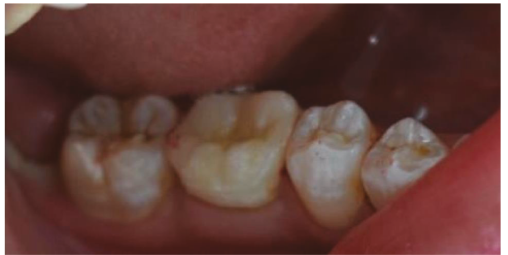
Figures 8: Try-in of the occlusion.